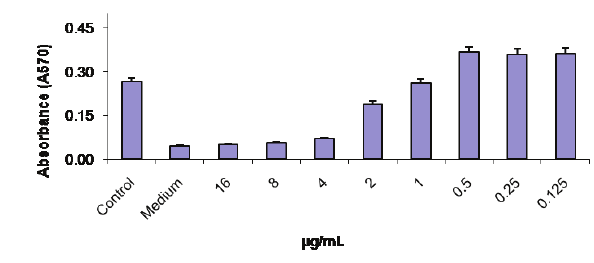
Figure 3. Cytotoxic effect of Macrovipera lebetina lebetina crude venom on L929 cells after two- hour incubation with different concentrations of venom and medium was refreshed and incubation continued for another 48 hours. Cell viability was determined by MTT assay, control was exposed to vehicle only which was taken as 100% viability. Data are expressed as mean ± SD.